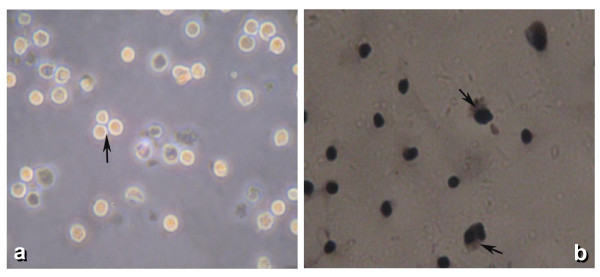
Isolated SSCs tend to congregate and form small cell clusters.